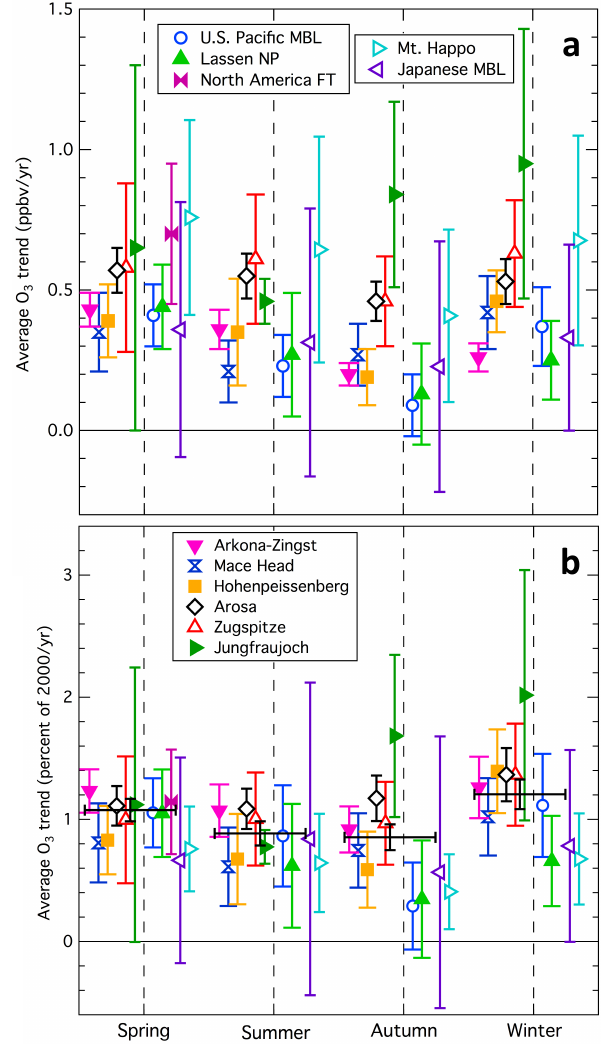
Fig. 7. Summary of average rate of increase in O 3 derived for the eleven northern mid-latitude data sets in each season. The order of the sites is the same as in Fig. 6. (a) Rates given as ppbvyr − 1 de- rived from the slopes of linear regressions as described in the text. (b) Rates given as percentage of the year 2000 intercept defined as the ratio of the slope in (a) to the intercept in Fig. 6. The black plus symbols indicate the averages with confidence limits of these rates for all European and North American sites.